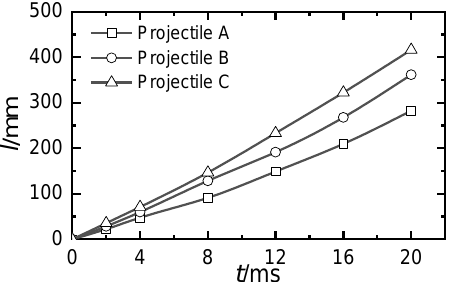
Figure 4. Gas-curtain displacement ( p max = 9.9 MPa).